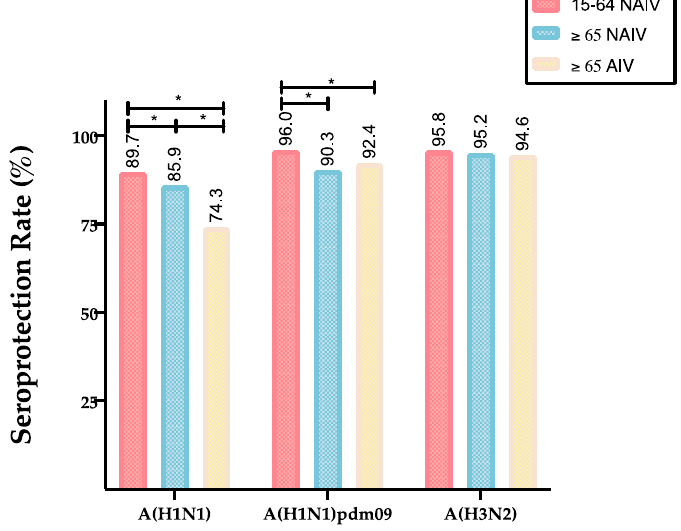
Figure 3. Seroprotection rate after vaccination of different age cohorts against influenza A strains / subtypes. Statistical signification between cohorts ( p < 0.05) is marked with a line and * in all plots.